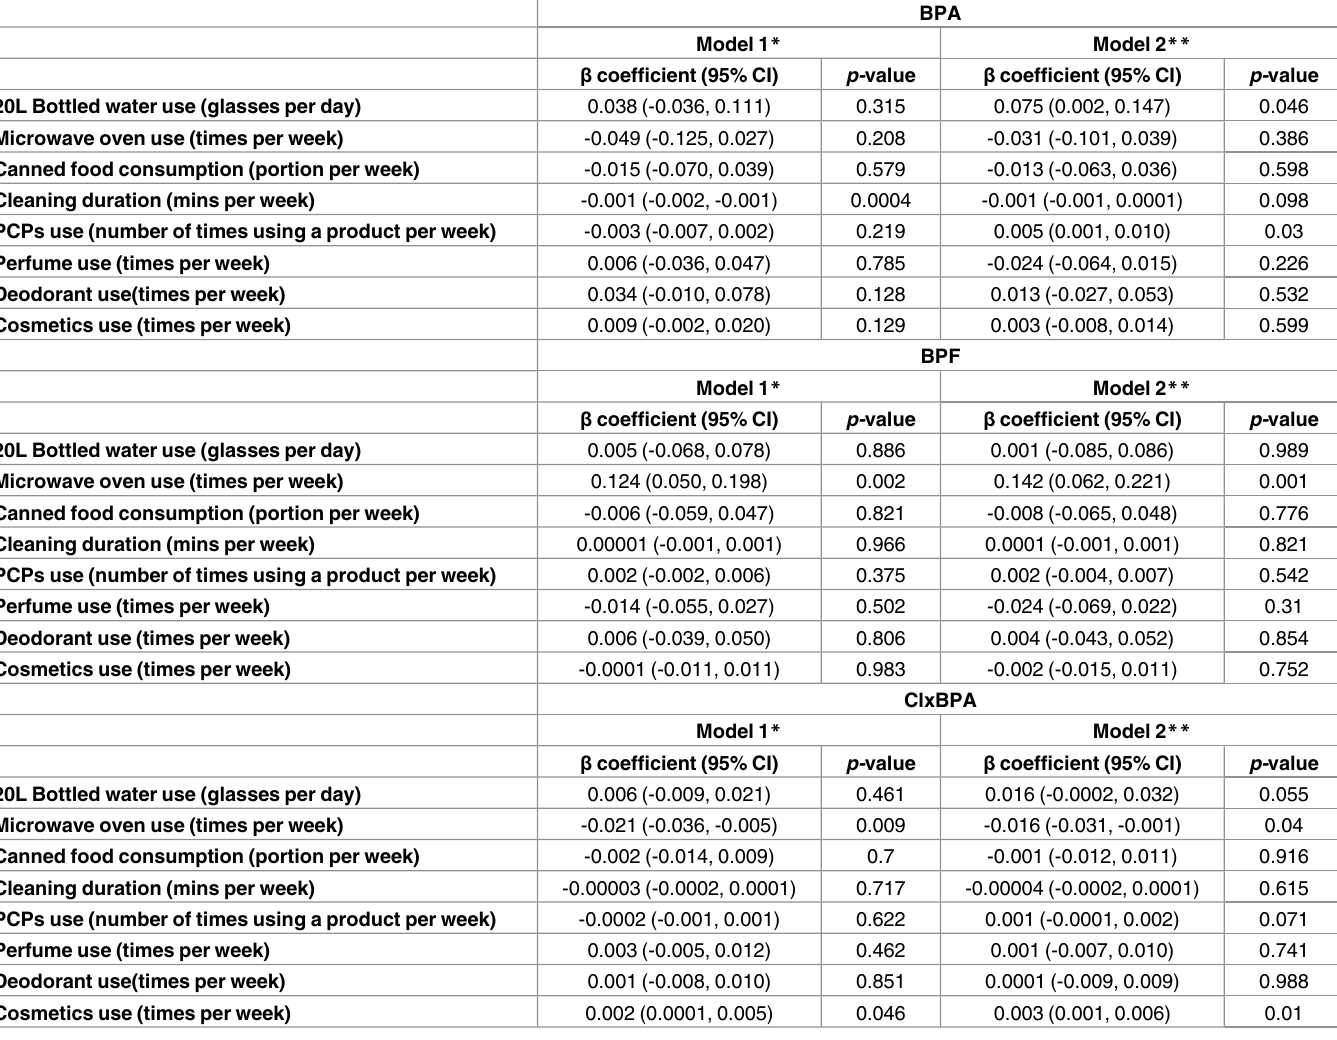
Table 2. Linear regression analysis of the exposure habits as determinants of spot urinary BPA levels (creatinine unadjusted, log-transformed) for the pooled study population.